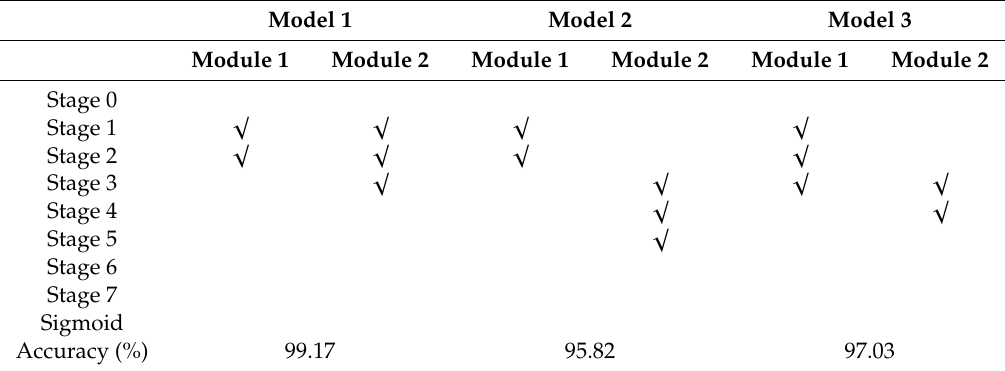
Table 5. Fault diagnosis results of the three models with different module orders.